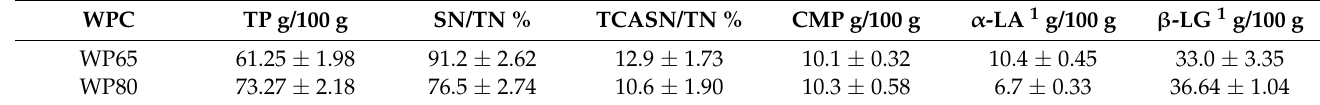
Table 2. Protein composition of substrates WPC powders of sheep/goat origin manufactured from Feta cheese whey. Codes and abbreviations are explained in Sections 2.1 and 2.2.1 Means and standard deviations of three